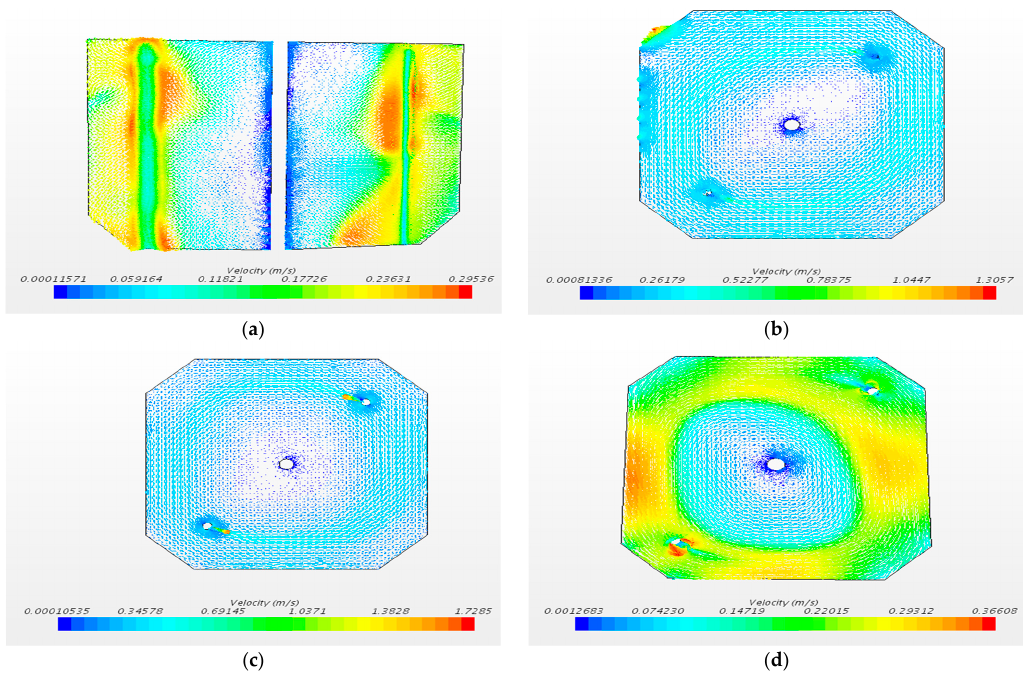
Figure 13. ( a ) middle longitudinal section, ( b ) H = 16.5 m cross section, ( c ) H = 8.5 m cross section, ( d ) H = 1.5 m cross section. From the analysis of the Figure 13 and calculated results, it is obvious that the velocity gradi- ent of the flow field is low, the distribution of the flow field is uniform, and the effect of particu- late matter emission is better when the bottom displacements of the two inlet pipes are 40% and 30%. (3) Bottom outflow ratio of 20%